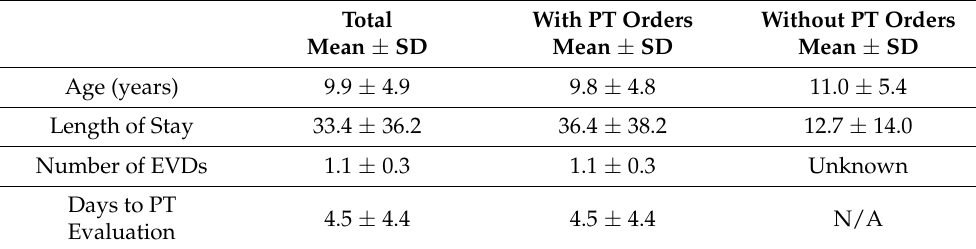
Table 2. Mean Age, Length of Stay, Number of EVDs, Days to